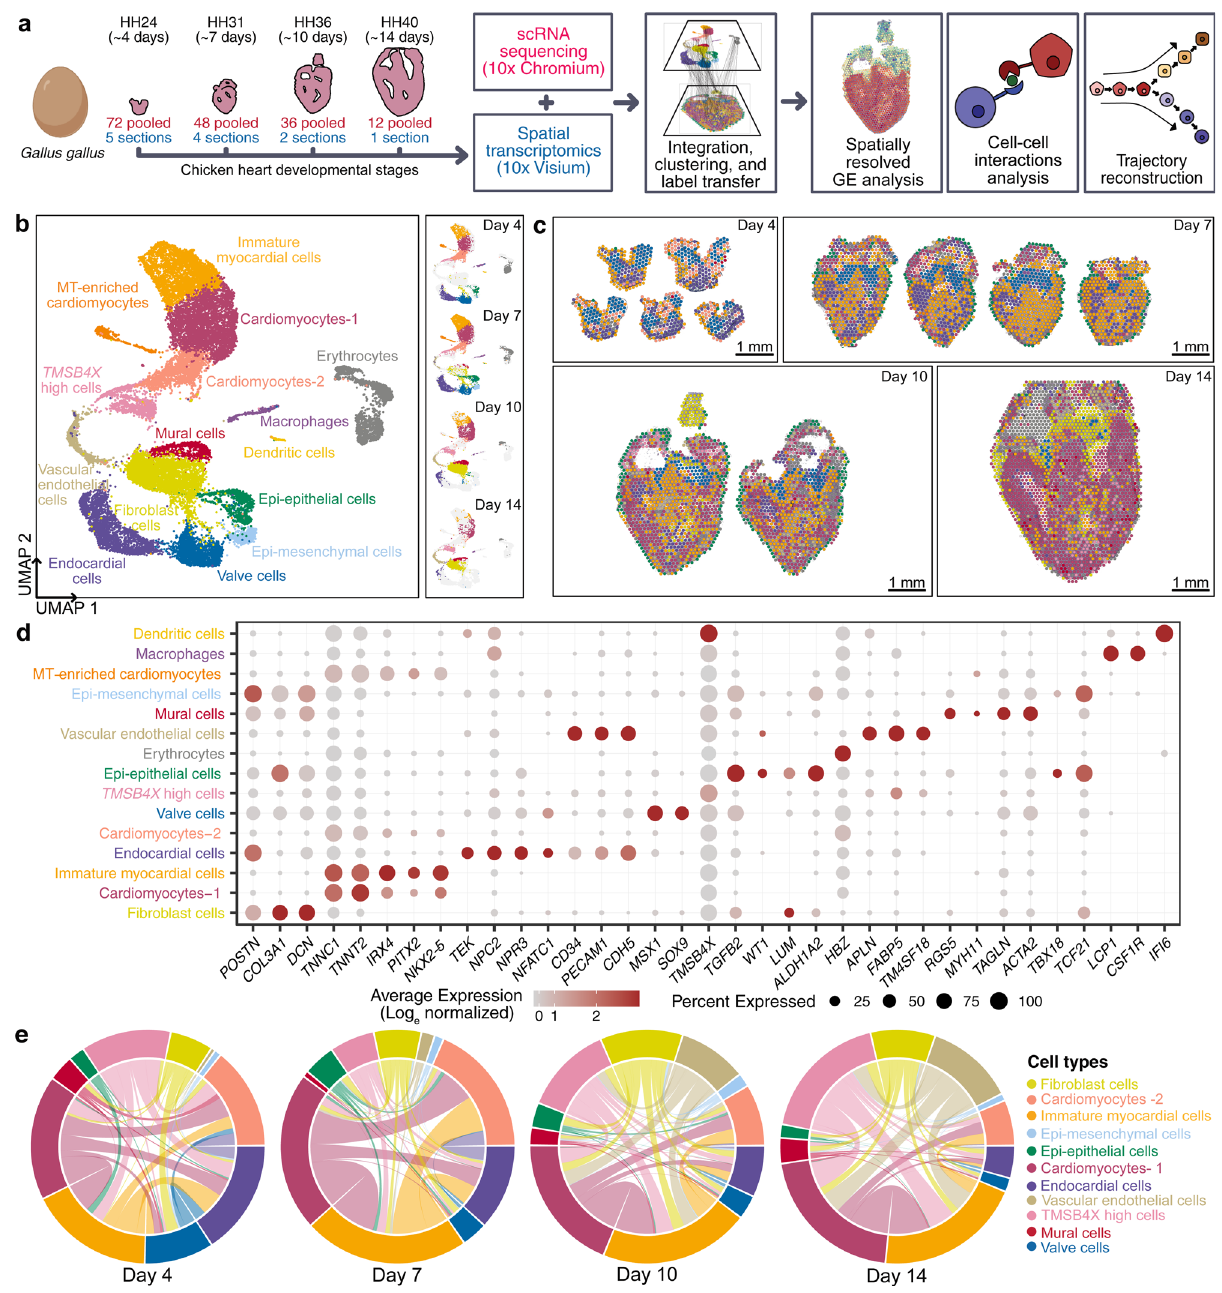
Fig. 1 Spatially resolved single-cell transcriptomic atlas of developing embryonic chicken hearts. a Experimental work fl ow and analysis for single-cell RNA-seq and spatial RNA-seq of embryonic chicken ( Gallus gallus ) hearts at four stages of development. b UMAP projection of 22,315 single-cell transcriptomes clustered by gene expression and colored by cell type (Left). UMAP projection of single-cell transcriptomes colored by cell type and split by developmental stage from day 4 to day 14 (Right). c Spatial RNA-seq barcoded spots labeled by scRNA-seq cell type with maximum prediction score for four developmental stages. Only spots under tissue sections are shown. d Gene expression of cell type-speci fi c markers. The size of the dot represents the percentage of cells in the clusters expressing the marker and the color intensity represents the average expression of the marker in that cluster. e Chord diagrams representing cell-type proximity maps showing the degree of colocalization of cell-type pairs within spots in spatial RNA-seq data across developmental visualized them as chord diagrams (Fig. 1e). We found a signi fi cant colocalization of myocardial cells with endocardial cells at day 7 and with vascular endothelial and fi broblast cells at day 10 and day 14. This was expected given that endocardial cells line the trabeculated myocardium at day 7 and that vascular endothelial cells and fi broblasts are present in the compact myocardium by day 10.